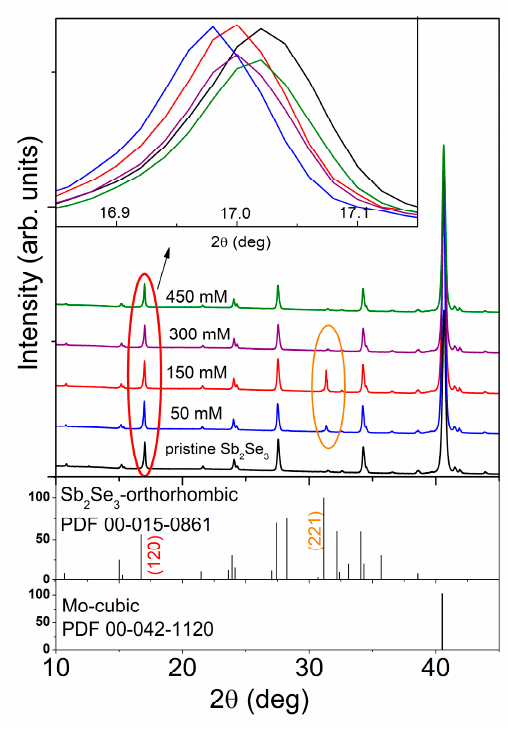
Figure 2. XRD patterns of the pristine Sb 2 Se 3 film and those thermally treated in glycerol at various concentrations of SbCl 3 for 90 min at 300 °C.